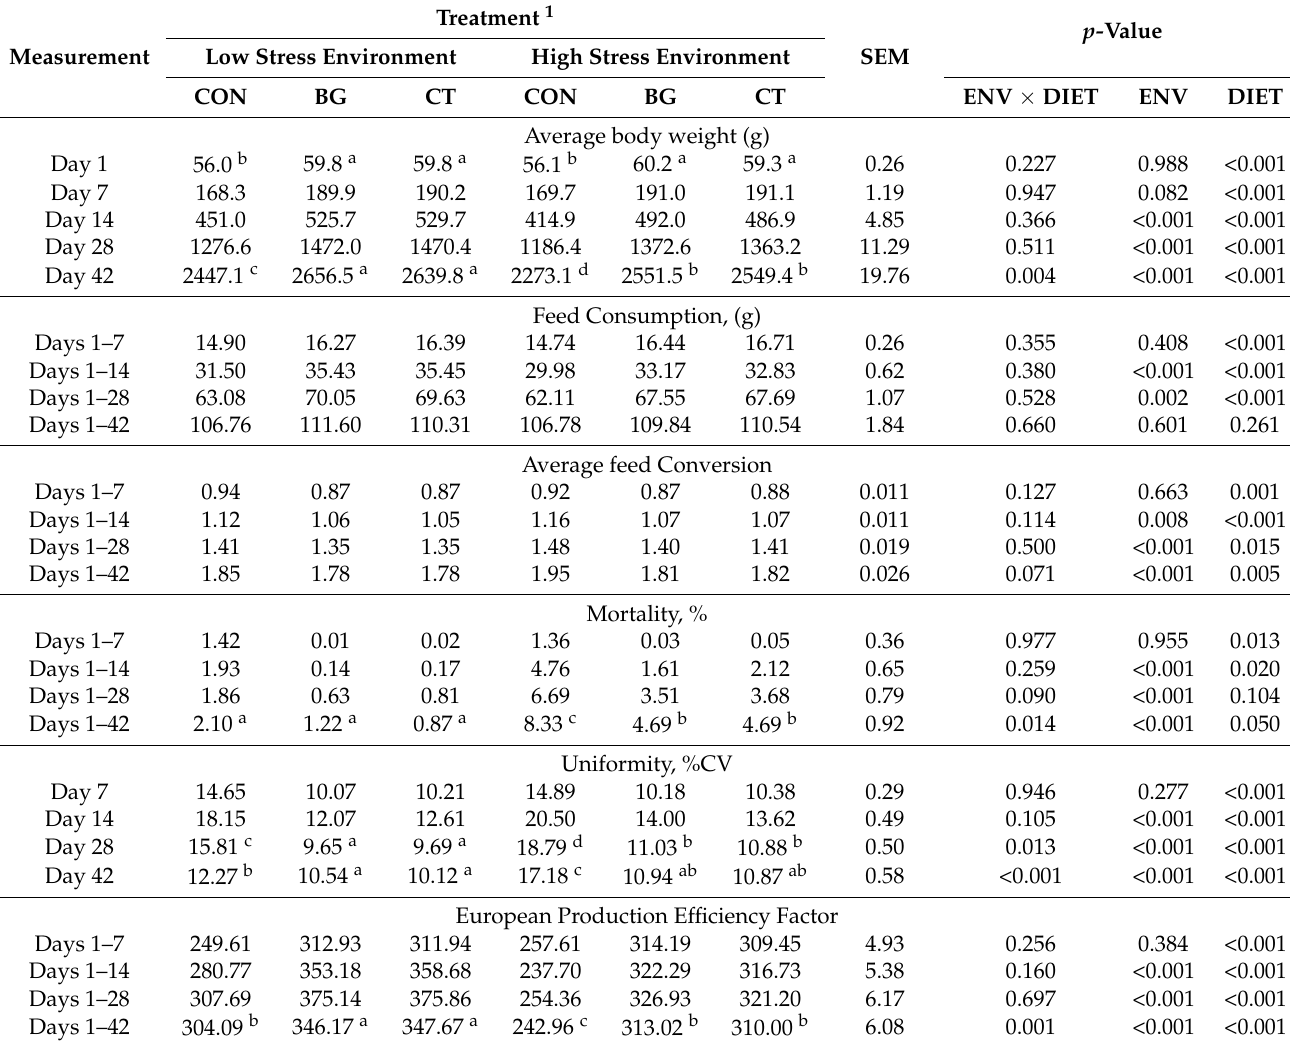
Table 2. Live performance of birds fed betaGRO and celluTEIN under different environmental